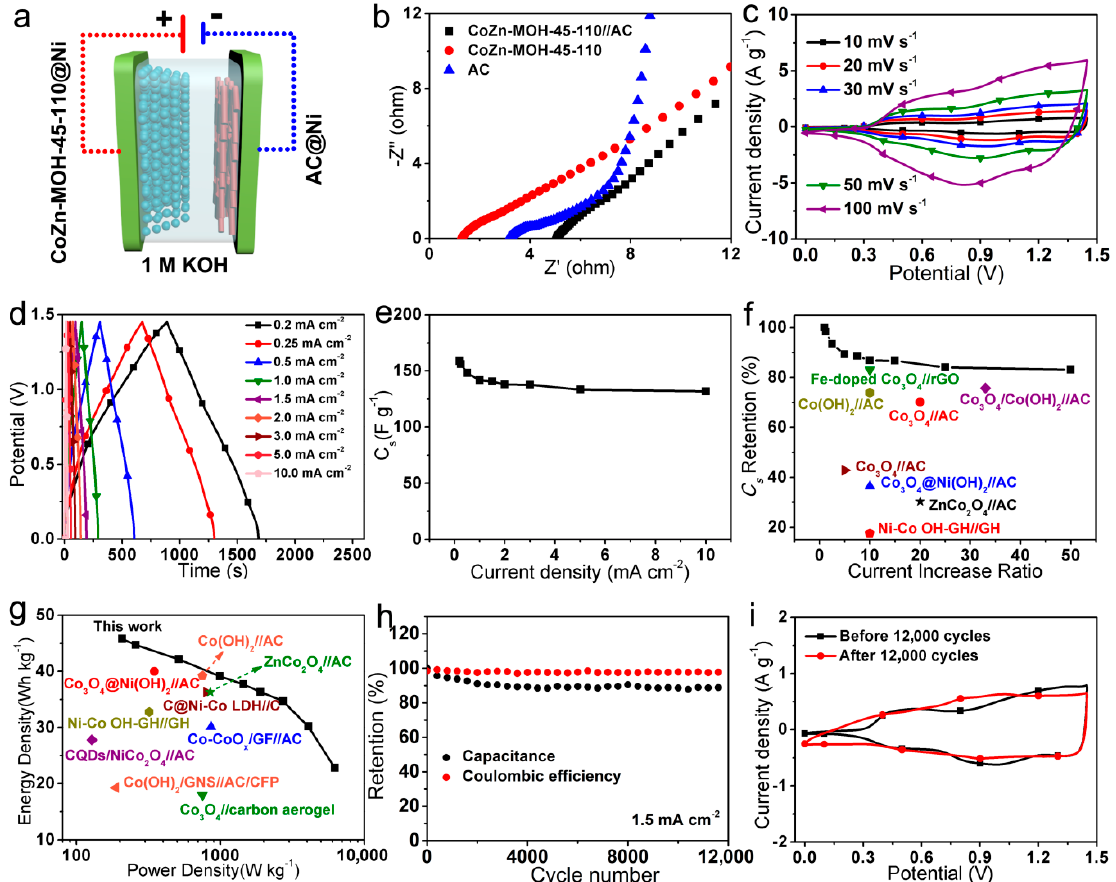
Figure 7. ( a ) Schematic diagram, ( c ) CV curves, ( d ) galvanostatic CD curves, ( e ) C s , ( h ) cycling performances, and ( i ) CV curves at 10 mV·s –1 before and after the cycling performance test of as-assembled CoZn-MOH-45-110//AC asymmetric supercapacitor (ASC). ( b ) Nyquist plots of individual CoZn-MOH-45-110 electrode, AC electrode, and ASC. Comparisons of ( f ) rate capabilities and ( g ) energy densities of this ASC and similar ASCs.